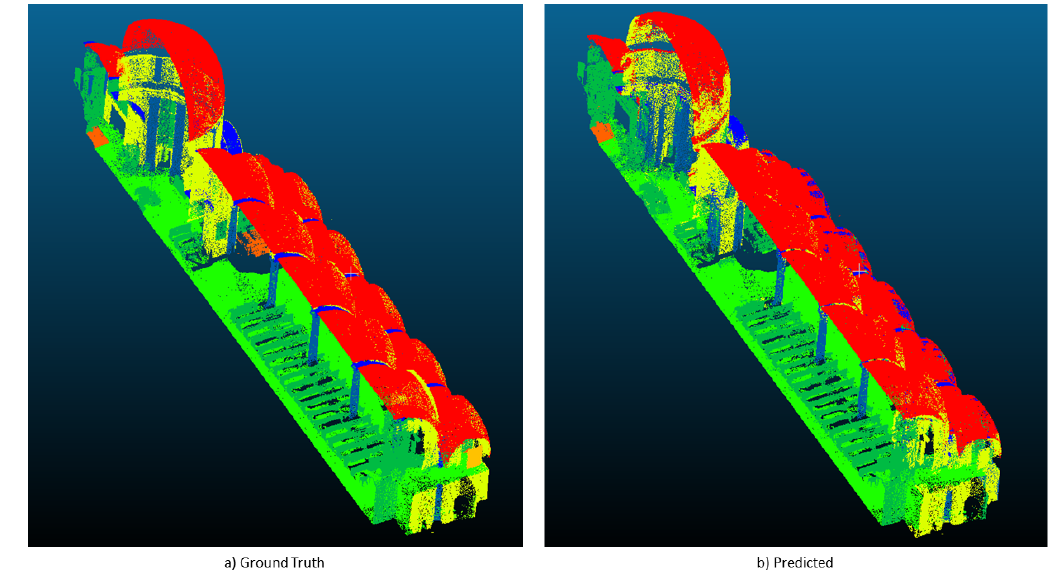
Figure 5. Ground Truth and Predicted Point Cloud, by using our Approach on Trompone’s Test side.